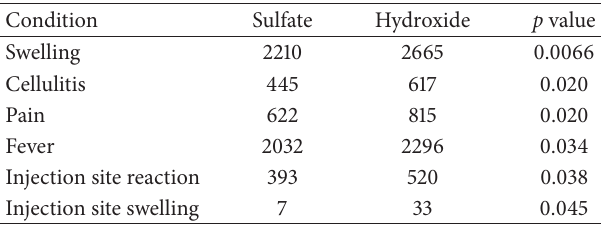
Table 7: Adverse reactions reported in VAERS for sulfate versus hydroxide in age-matched samples, and the likelihood that the contrasts observed in these distributions could have occurred by chance ( p < 0.05).